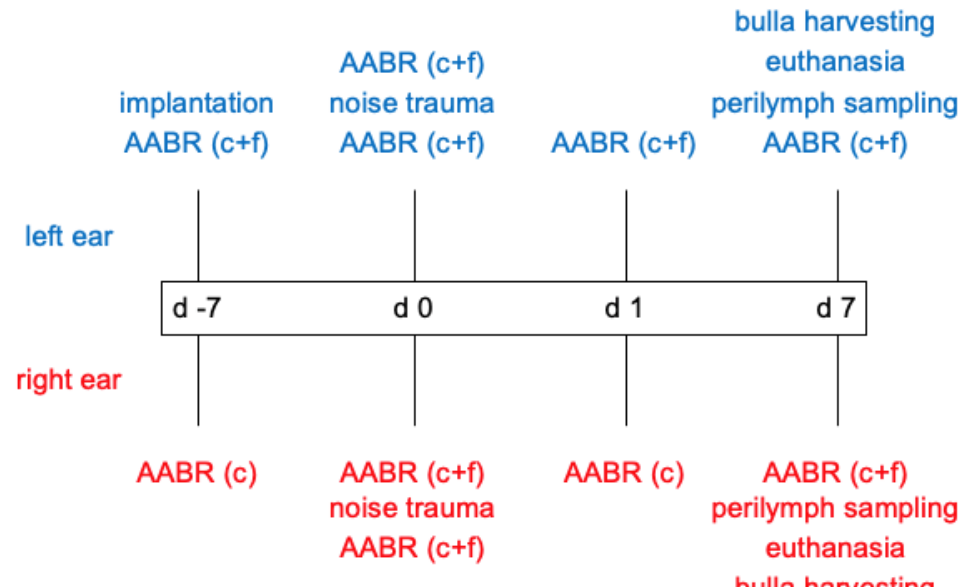
Figure 1. Overview over the experimental timeline, respective interventions, and scope of the AABR measurements for implanted (left, blue) and contralateral (right, red) ears. c = click, f = frequency-specific (0.5 kHz, 1 kHz, 2 kHz, 4 kHz, 8 kHz, 16 kHz, 32 kHz, 40 kHz).